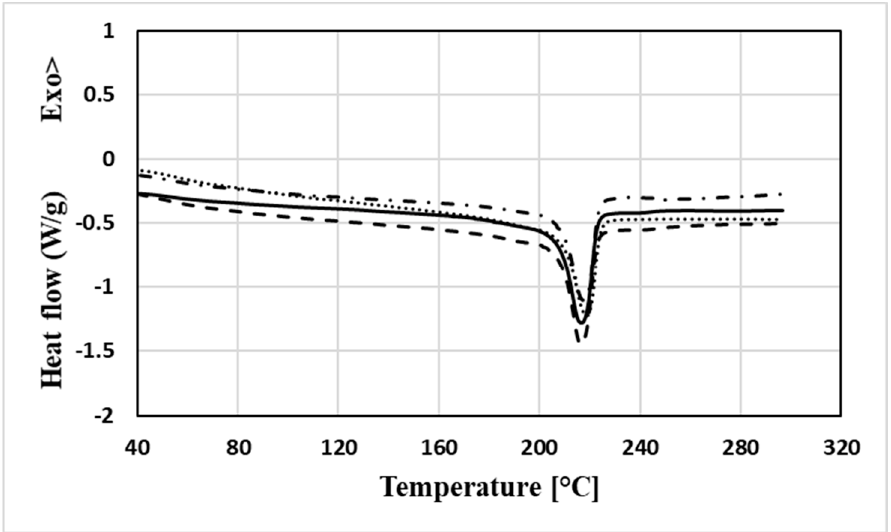
Figure 1. Calorimetric curves relating to the second heating ramp (solid line: PA6, dashed line: PA6 + 1% GNP, dash and dot line: PA6 + 3% GNP, dotted line: PA6 + 5% GNP). Table 1. Calorimetric parameters.